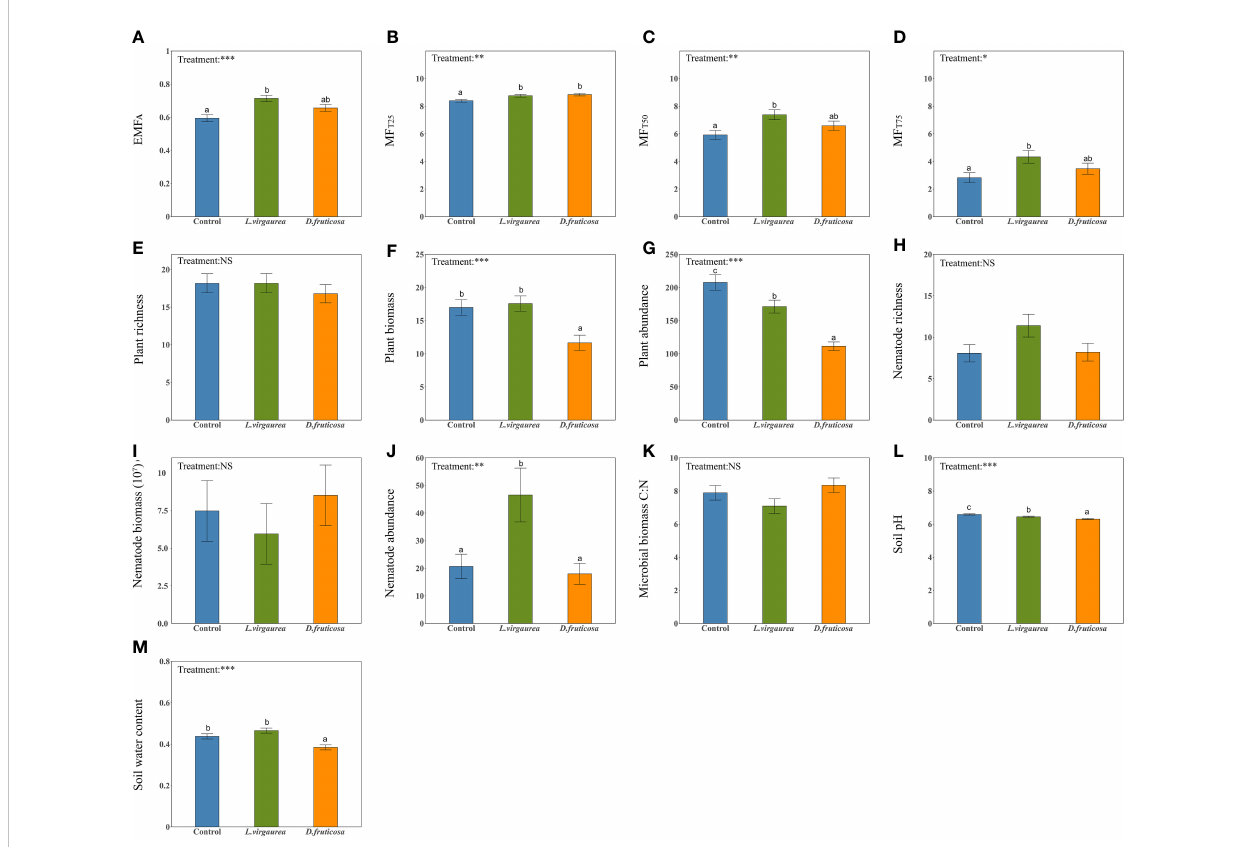
FIGURE 1 The effects of dominant plants on EMF A (A) , MF T25 (B) , MF T50 (C) , MF T75 (D) , plant richness (E) , plant biomass (F) , plant abundance (G) , nematode richness (H) , nematode biomass (I) , nematode abundance (J) , Microbial biomass C:N ratio (K) , soil pH (L) , soil water content (M) . Different lowercase letters within panels indicate signi fi cant ( p -value < 0.1) differences between treatment means, after using Tukey ’ s method to correct for multiple comparisons. Error bars represent means ± SE (NS, p > 0.05; * p < 0.05; ** p < 0.01; *** p <